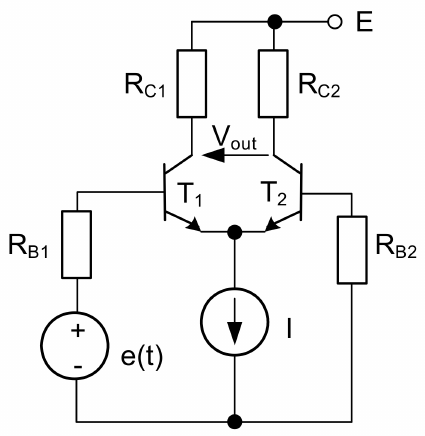
Figure 16. Diagram of the considered differential